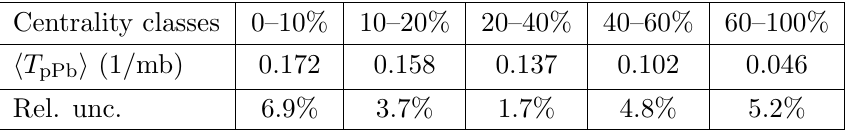
Table 2 . h T pPb i and relative uncertainties for each centrality class considered in the analysis. p{Pb collisions. The result is 0 R promptD